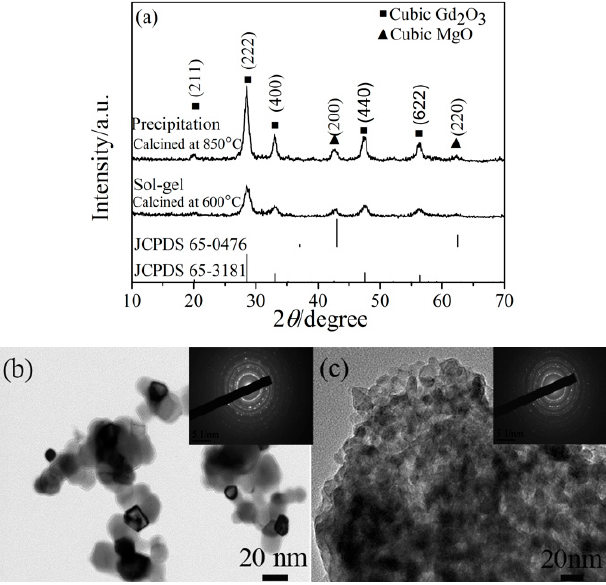
Figure 2. ( a ) XRD patterns of the nanocomposite powders preparation via different methods. TEM images of the calcined nanopowders synthesized by different methods; ( b ) urea precipitation; and ( c ) sol–gel. The insets are the SADPs of the calcined nanopowders synthesized by different methods.